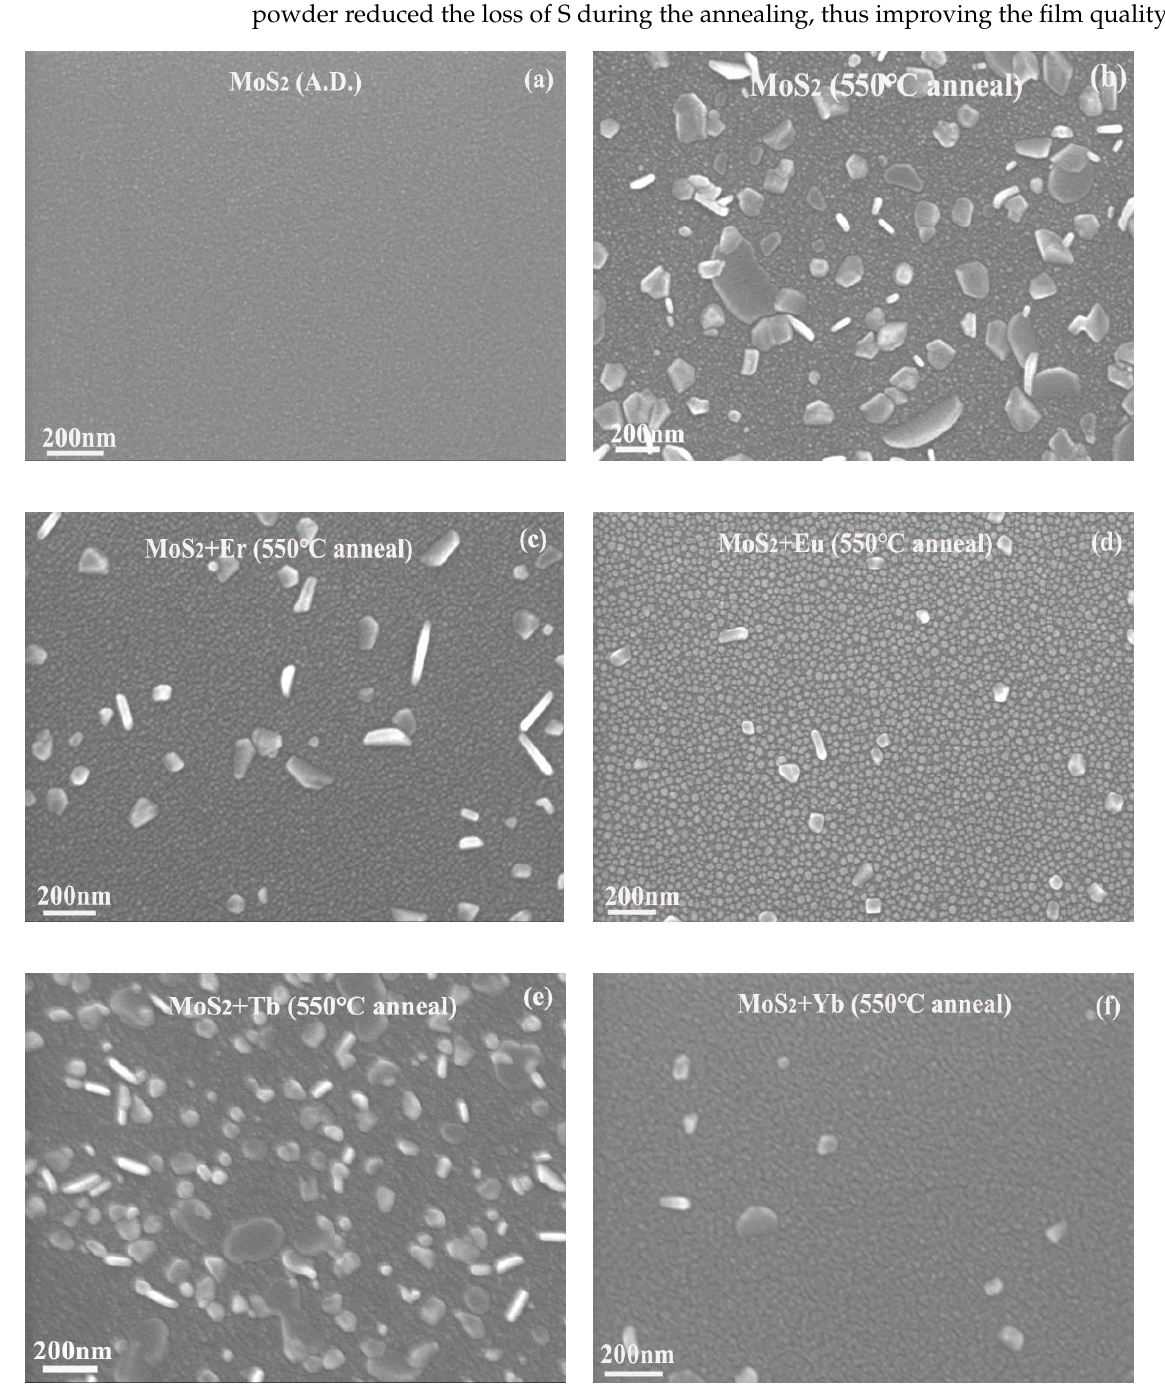
Figure 3. Surface morphologies of the samples deposited on SiO 2 /Si substrate. ( a ) A.D. MoS 2 and ( b ) MoS 2 after the 550 °C annealing in Ar + H 2 gas ambience. ( c – f ) The SEM images of the RE (Er, Eu, Tb, Yb)-doped MoS 2 samples after identical